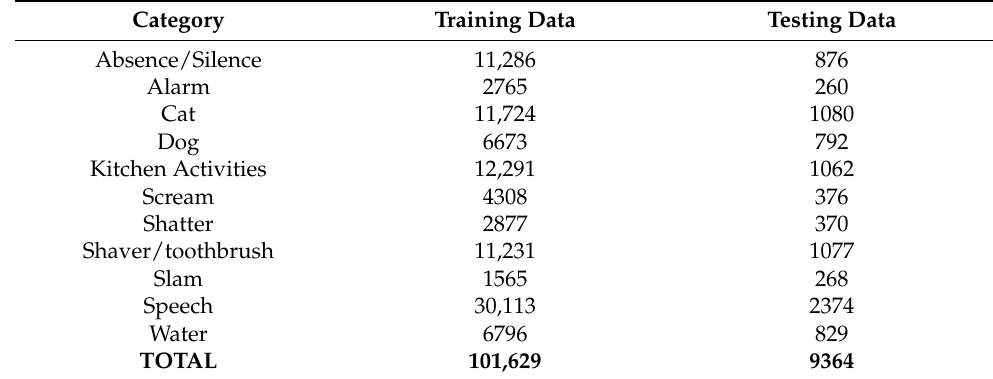
Table 2. Summary of the Source Node Estimation